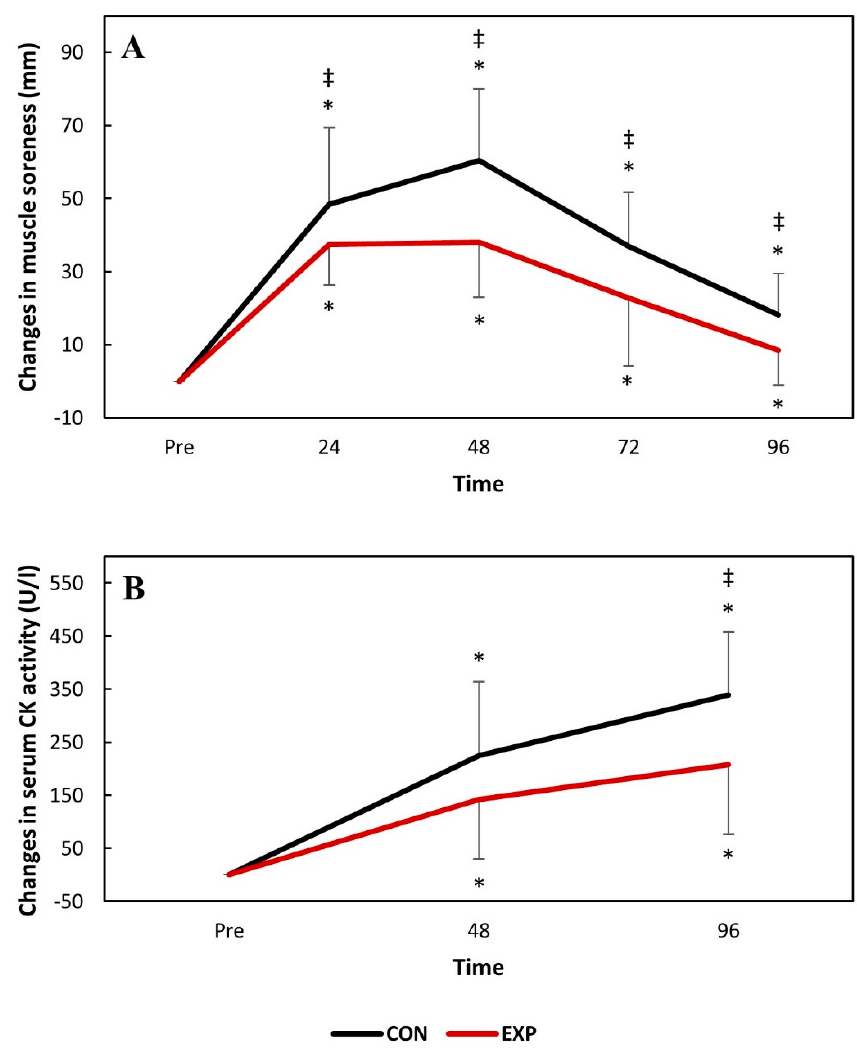
Figure 4. The changes in knee extensor muscle soreness (A) and serum creatine kinase (CK) activity (B) over time following downhill running. * p < 0.05 compared to baseline values in the same group; ‡ p < 0.05 compared to the experimental group at the same time-point. CON: control group; EXP: experimental group.